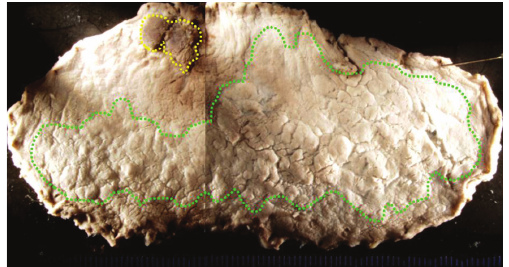
Figure 2: Formalin-fixed endoscopically resected specimen. The yellow-dotted line and the green-dotted line indicate the extent of the 0-I lesion and the 0-IIa lesion, respectively. The intervening mucosa between the two lesions was